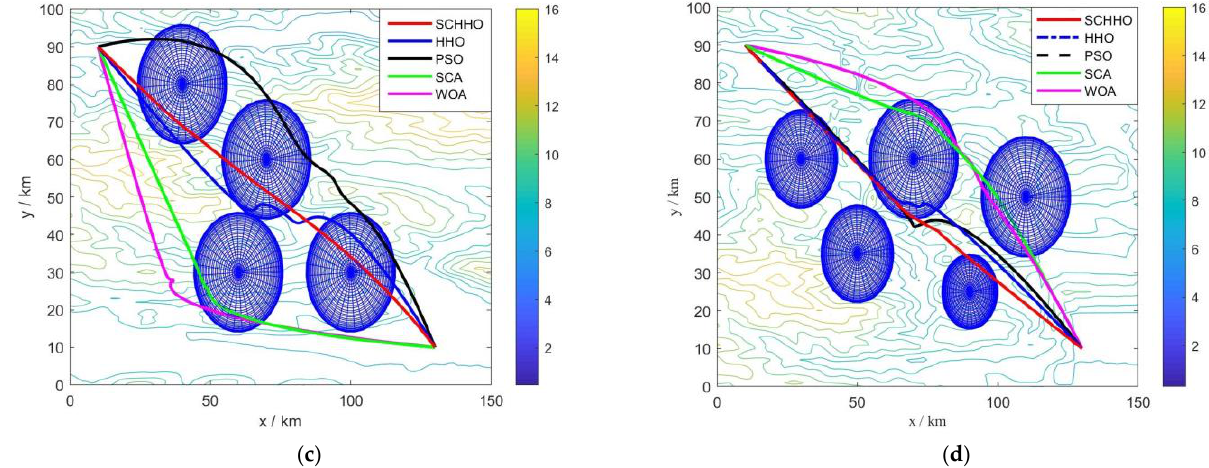
Figure 5. Path planning results in 2D contour map. ( a ) Case 1. ( b ) Case 2. ( c ) Case 3. ( d ) Case 4.